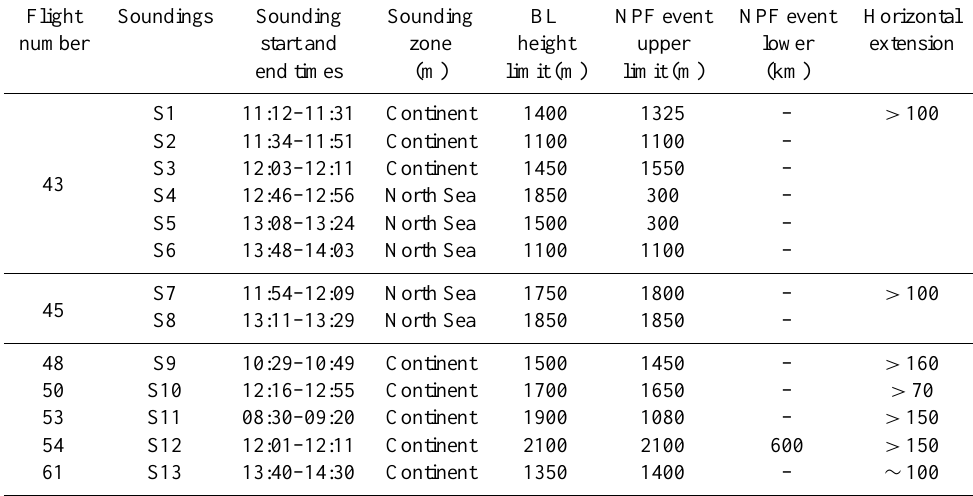
Table 3. Horizontal and vertical extension of all detected new particle formation (NPF) events. In addition to the vertical extension of NPF events is presented the top of the boundary layer (BL), both derived from numerous ATR-42 ascents and